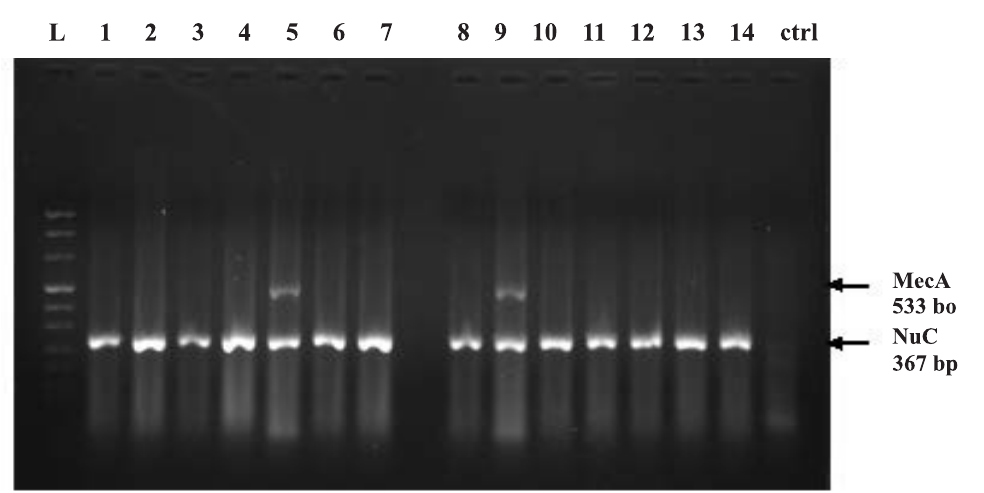
Fig. 2. Agarose gel images; Showing PCR amplification of specific Nuc (367 bp) and MecA (533 bp) genes of Staphylococcus aureus isolates: Lane- L is DNA Ledder (1000bp), Lane 1 to 14 – PCR amplification of Nuc gene, Lane 5, 9 – PCR amplification of MecA gene. Lane- ctrl is negative control.